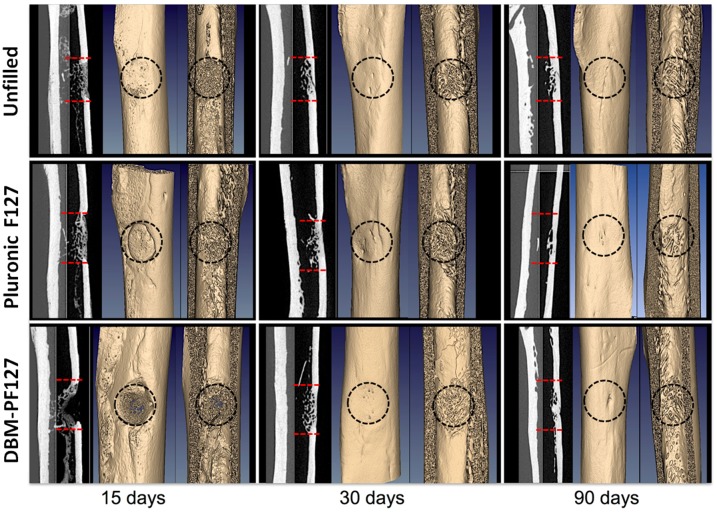
Micro-CT ex vivo images of rat femurs showing qualitatively the impact of the different treatments at the three time points.Dashed line indicate the defect edges.